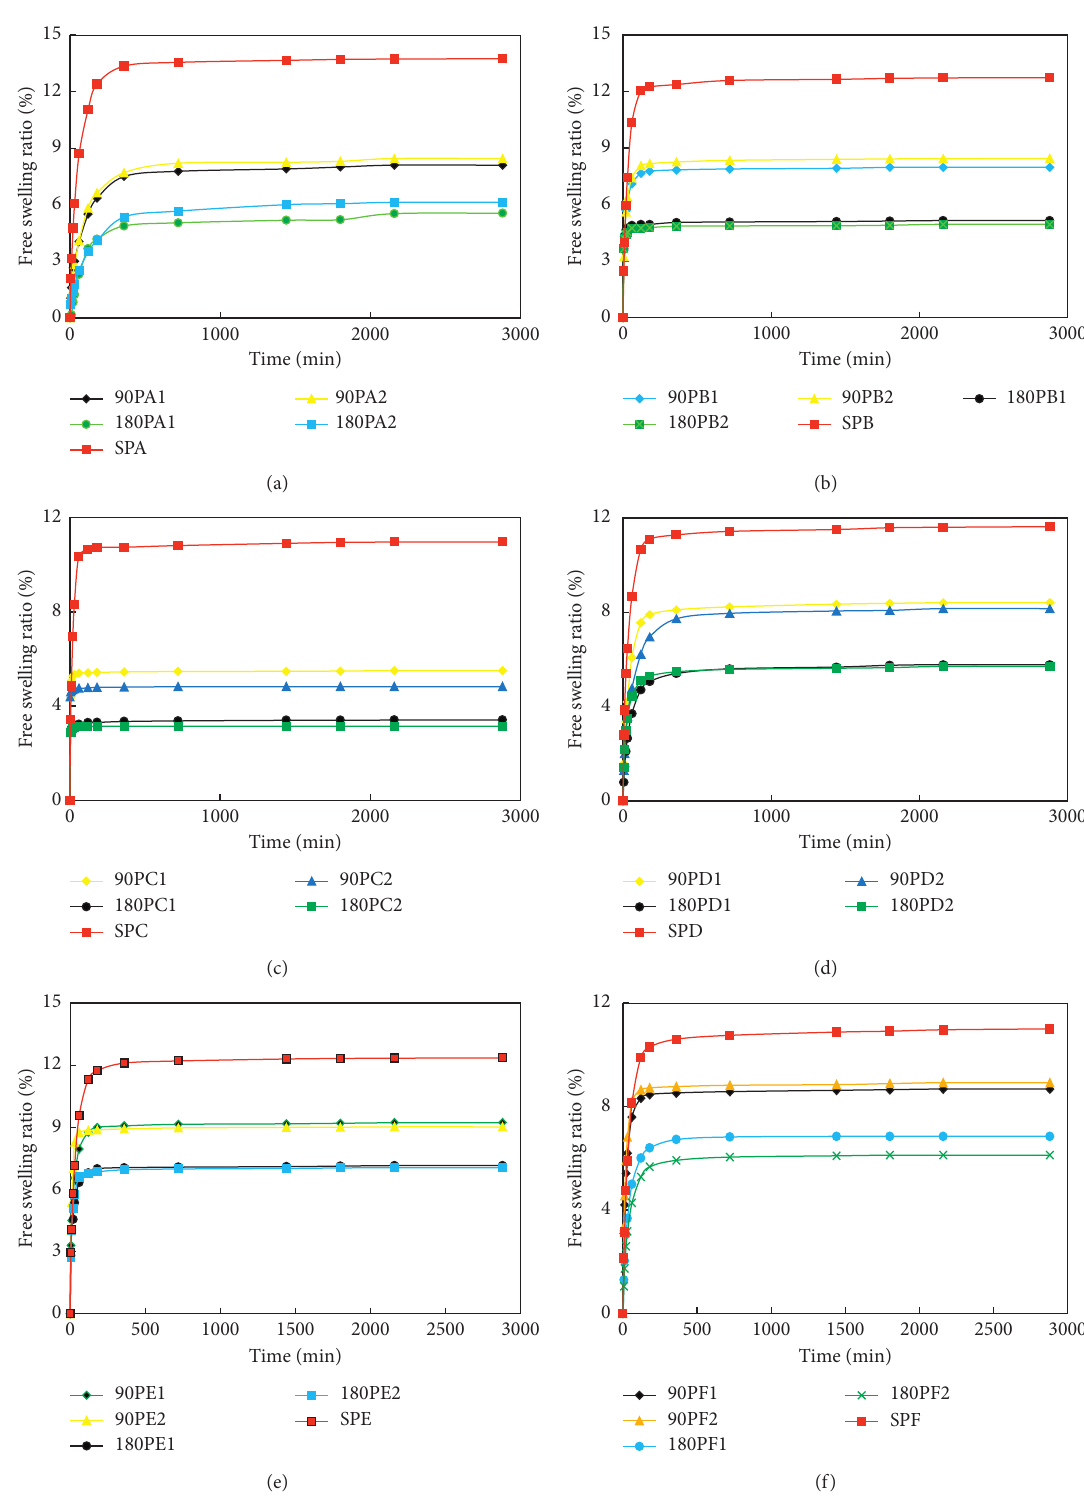
Figure 7: The expansion rate of soil in different soil layers varying with time: (a) 0 ∼ 5cm; (b) 5 ∼ 10cm; (c) 10 ∼ 15cm; (d) 15 ∼ 20cm; (e) 20 ∼ 25; (f) 25 ∼ 30 cm (90 and 180, the growth age; P, the root-soil composite sample; SP, the pure soil sample; a ∼ f, different sampling depths; 1 and 2, the parallel test group